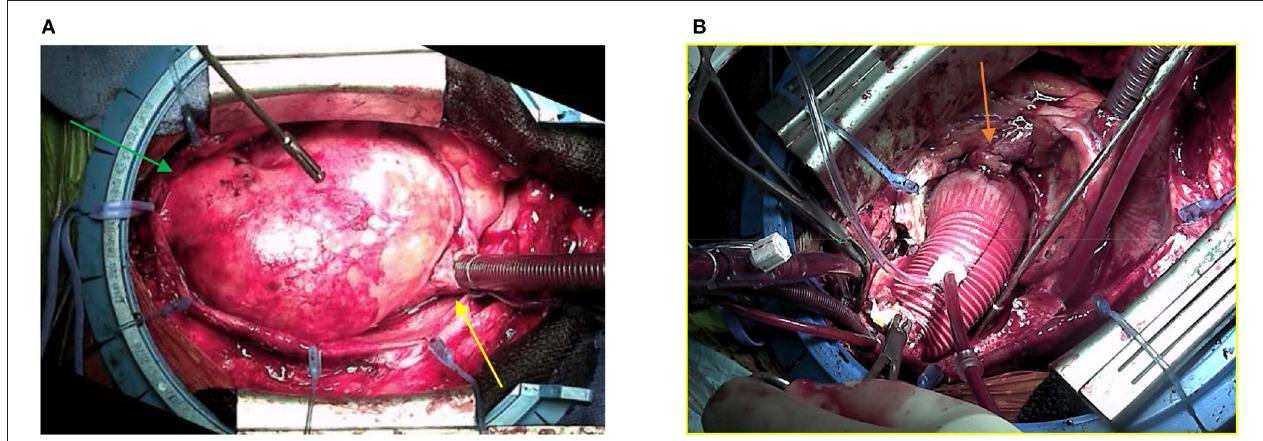
FIGURE 2 | (A) Surgical view of the mediastinum after sternotomy. The huge aneurysm of the ascending aorta (82 × 87mm) filled the whole cavity, displacing the heart into the left chest. The yellow arrow indicates the right atrium, and the green arrow indicates the aortic arch. (B) The ascending aorta has been replaced by the Dacron tube, leaving a free space that was previously filled by the aneurysm. The orange arrow indicates the reimplantation of the right coronary ostium.